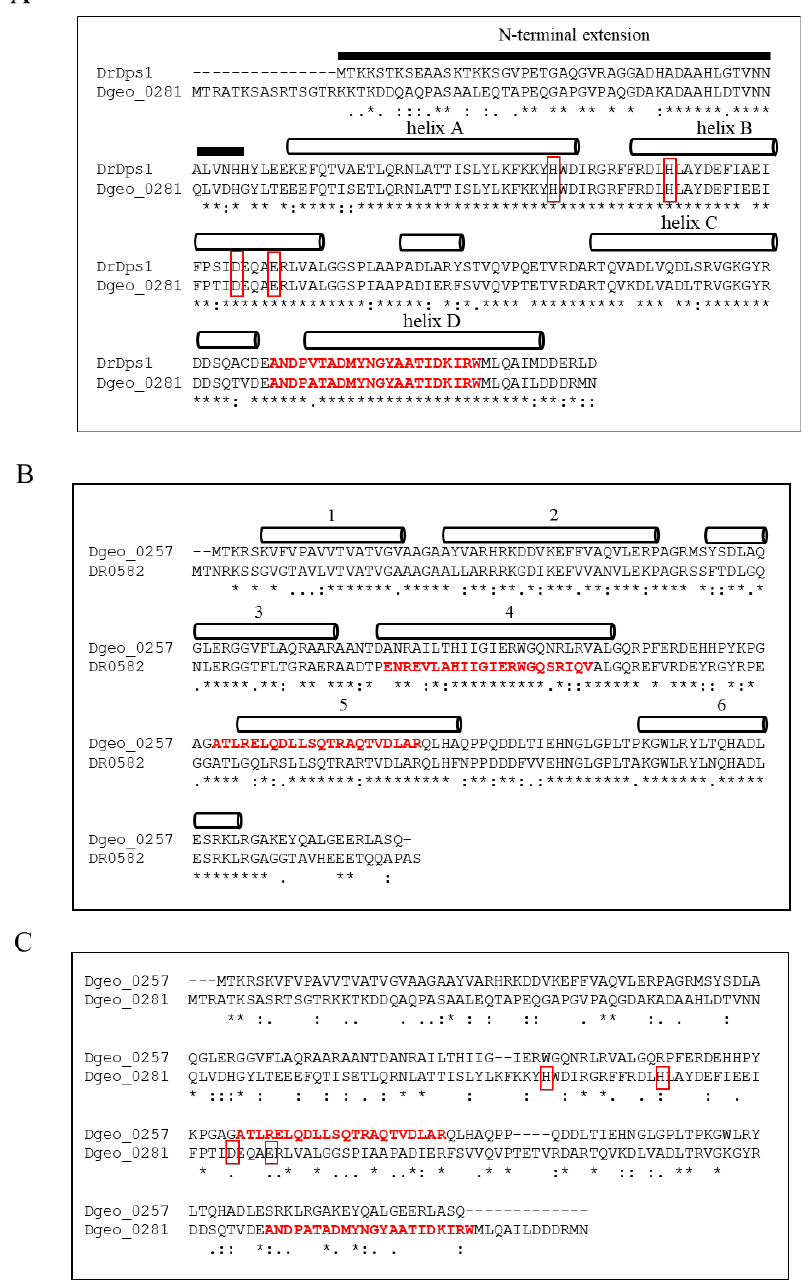
Figure 1. Comparison of amino acid sequences between DrDps1 and DgDps1 (Dgeo_0281) ( A ), a putative Dps Dgeo_0257 of D. geothermalis and a hypothetic protein DR0582 of D. radiodurans with 65.5% identity ( B ) and between DgDps1 and Dgeo_0257 with 11.5% identity ( C ). The secondary structure of the helix ( A , B ) and the ferroxidase active centre of DgDps1 with red boxes are marked ( A , C ). The conserved ferroxidase active centre is missing in Dgeo_0257 ( C ). Red words indicate the DNA-binding domains (HTH) predicted by Prabi (https://npsa-prabi.ibcp.fr/ accessed on 10 June 2022). The secondary structure of Dgeo_0257 was predicted by Jpred 4 (http://www.compbio. dundee.ac.uk/jpred4/ accessed on 1 June